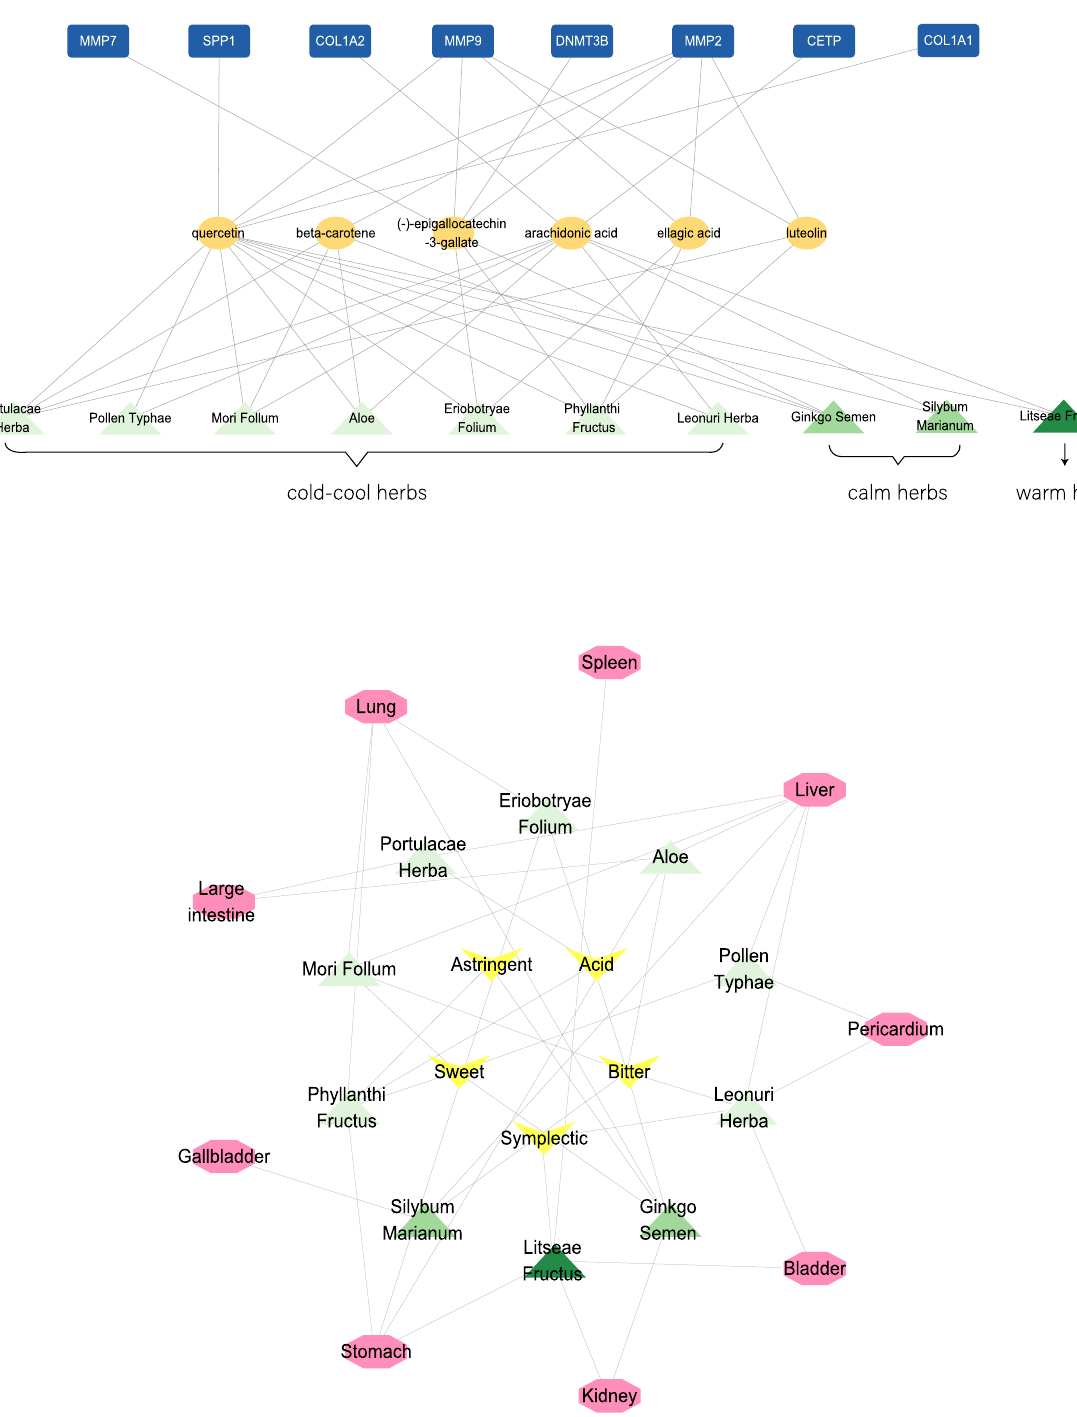
Figure 7. Herbs-Ingredients-Targets network ( a ) and Herbs-Taste-Meridian tropism ( b ) network. ( a ) Yellow nodes represent the active ingredients and the blue nodes represent the target genes. ( b ) Yellow nodes represent tastes and purple nodes represent meridian tropisms. In all networks, the light green nodes represent cold-cool herbs, medium green nodes represent calm herbs, and dark green nodes represent warm